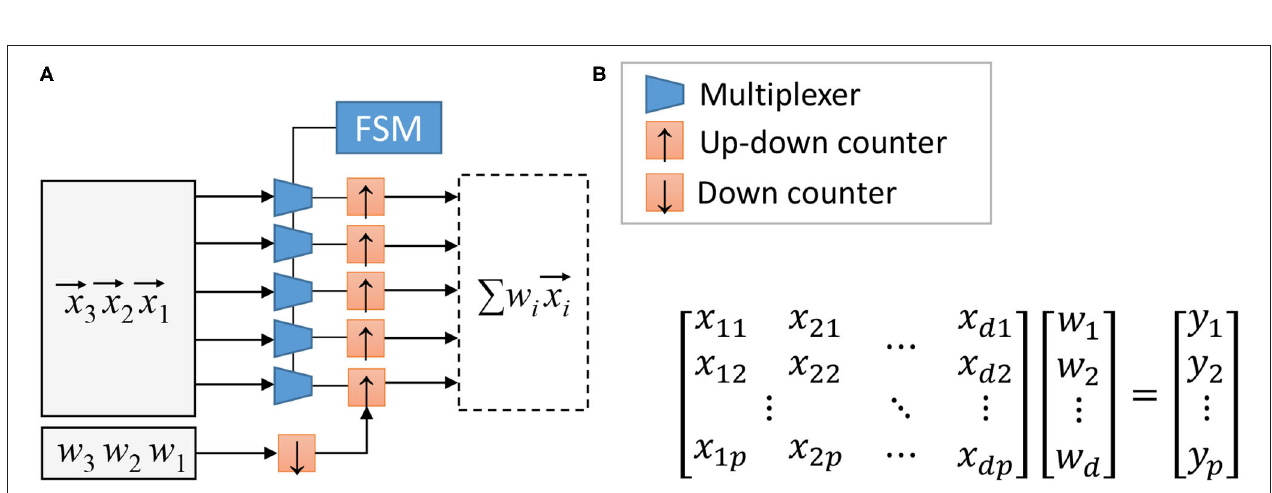
FIGURE 3 | (A) Stochastic computing (SC) matrix-vector multiplier (simplified) and (B) the operation it performs, where y j = P i w i x ij , reproduced from Sim and Lee (2017).